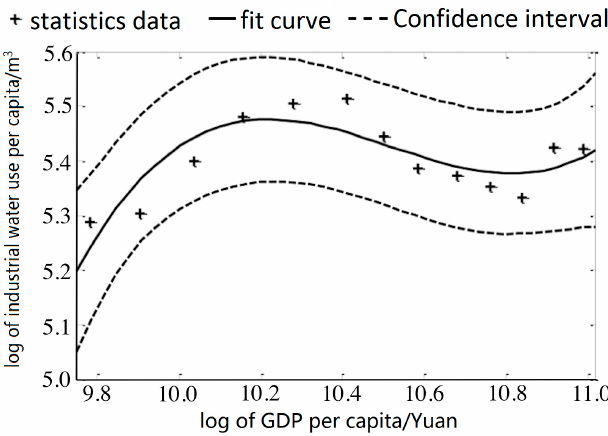
Figure 2. Estimated EKC of the eastern coastal region.